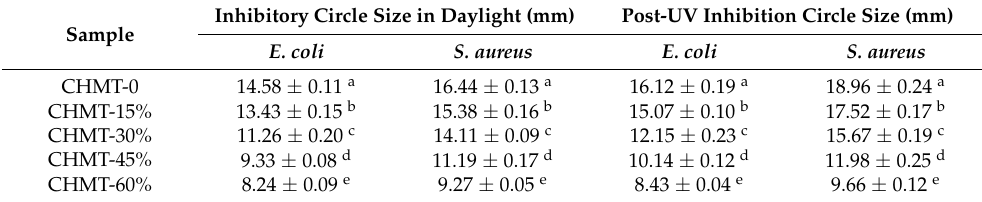
Figure 4. The different 3D-printing filling models of inner-layer material using CURA software, red line indicates the print boundary, yellow line indicates the gridded fill pattern; and the broad-spectrum bacteriostatic rates of CH, CHT and CHM under different light treatments. Table 5. Size of the inhibition zone of varying double-layer antibacterial chromogenic materials under varying light conditions.